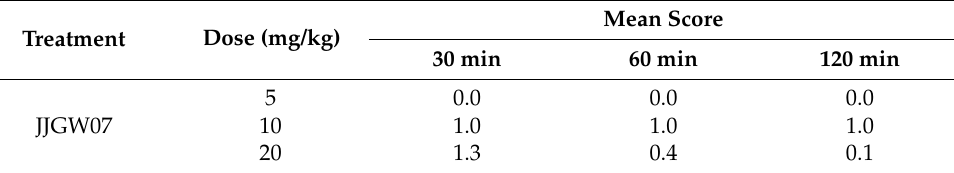
Table 4. The evaluation of the cataleptogenic properties of JJGW07. Treatment